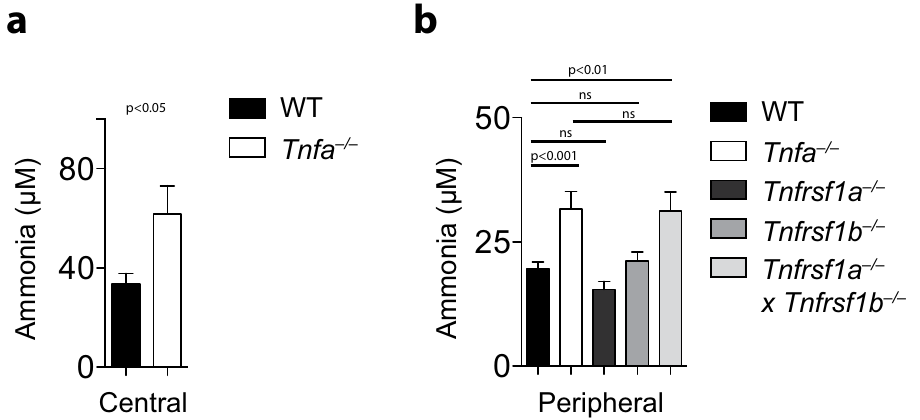
Figure 1. Hyperammonemia in TNF α - and TNFR1/TNFR2-deficient animals. (a) Ammonia levels were measured in blood samples harvested by cardiac puncture, central blood (right panel, n = 12) of WT and Tnfa − / − mice. ( b) Ammonia levels were measured in blood samples harvested from the retro orbital vein sinus of WT (n = 33), Tnfa − / − (n = 16), Tnfrsf1a − / − (n = 17), Tnfrsf1b − / − (n = 18), and Tnfrsf1a − / − Tnfrsf1b − / − animals (n =